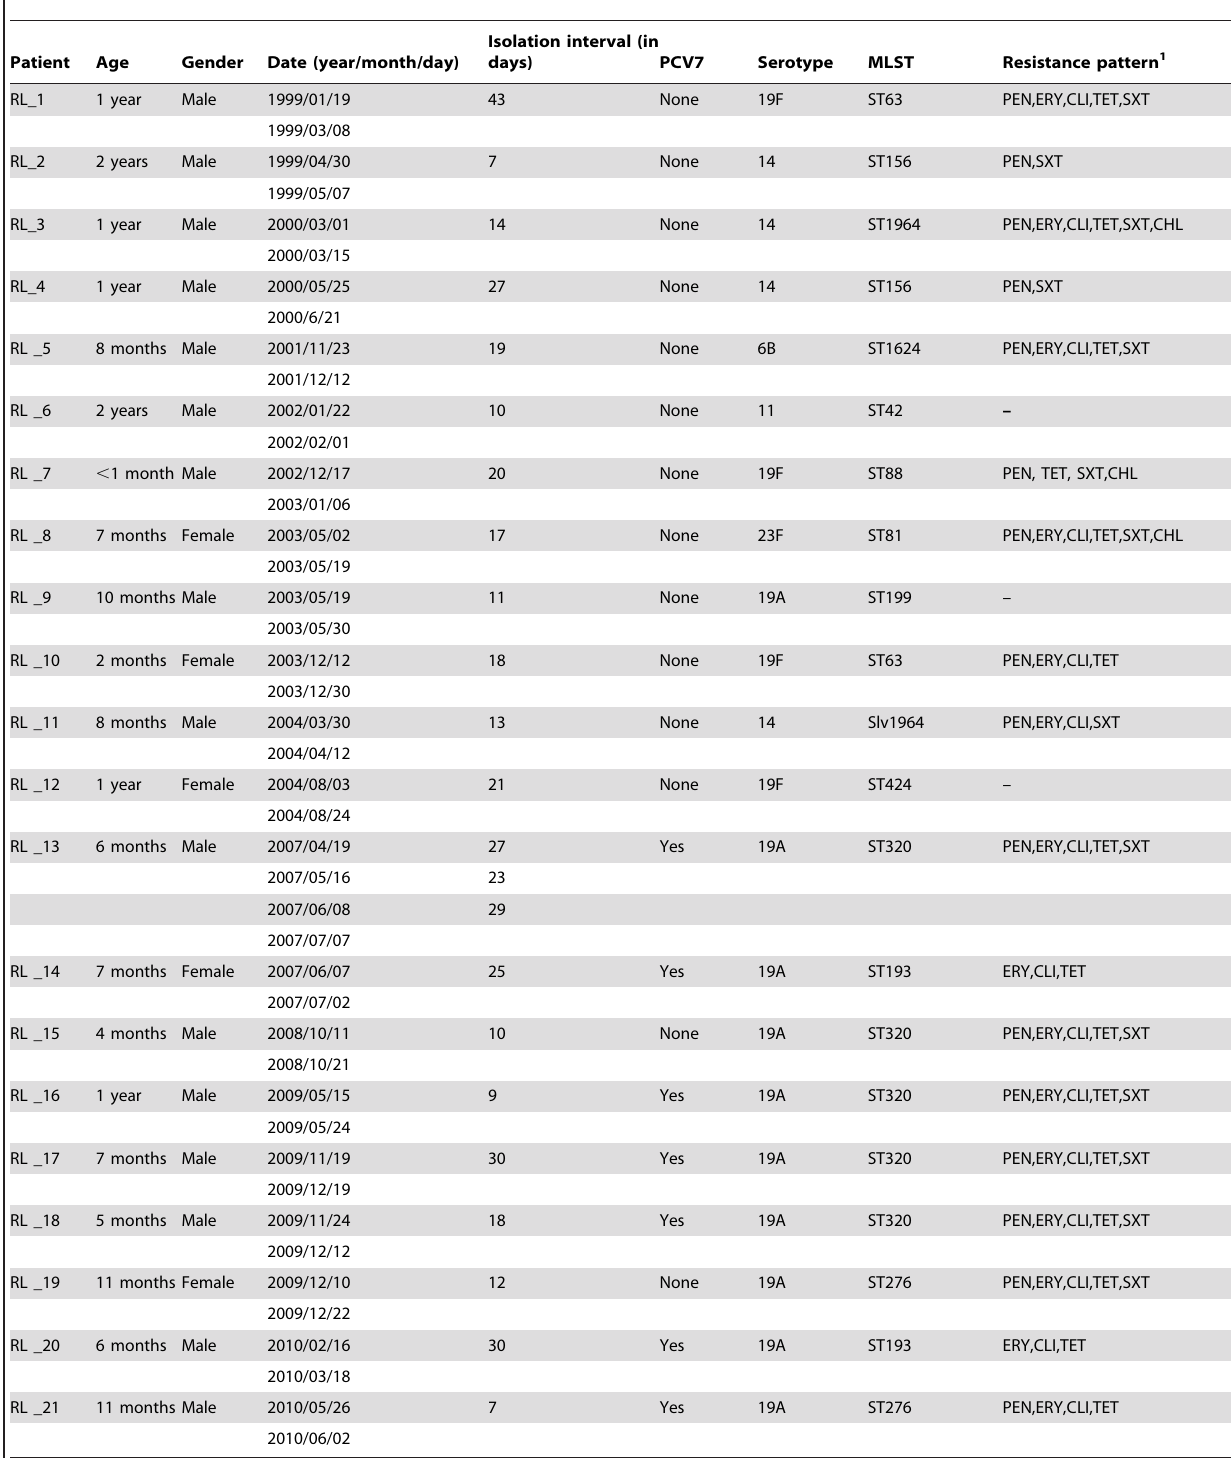
Table 3. Relapses. Patients with a second episode or more of infection in an interval of between 7 and 90 days caused by isolates with the same serotype and